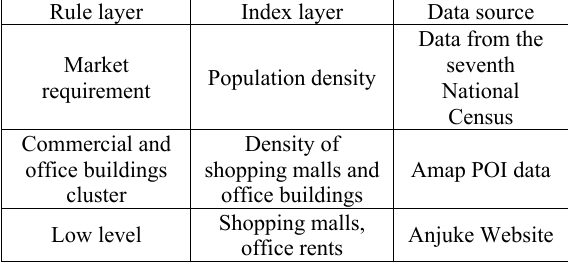
Table 4 . Model index selection.